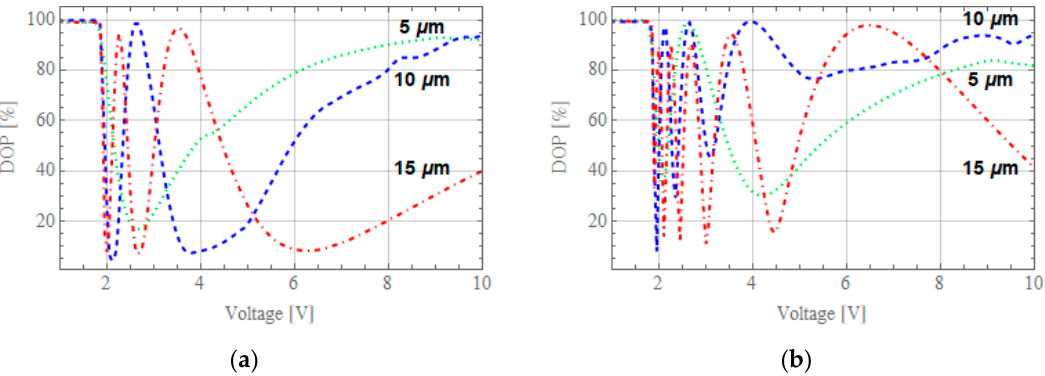
Figure 3. DOP as a function of the voltage for PVAN cells with thicknesses: 5 μ m (green dotted line), 10 μ m (blue dashed line) and 15 μ m (red dot-dashed line) for input SOP: ( a ) linear H and ( b ) circular R.